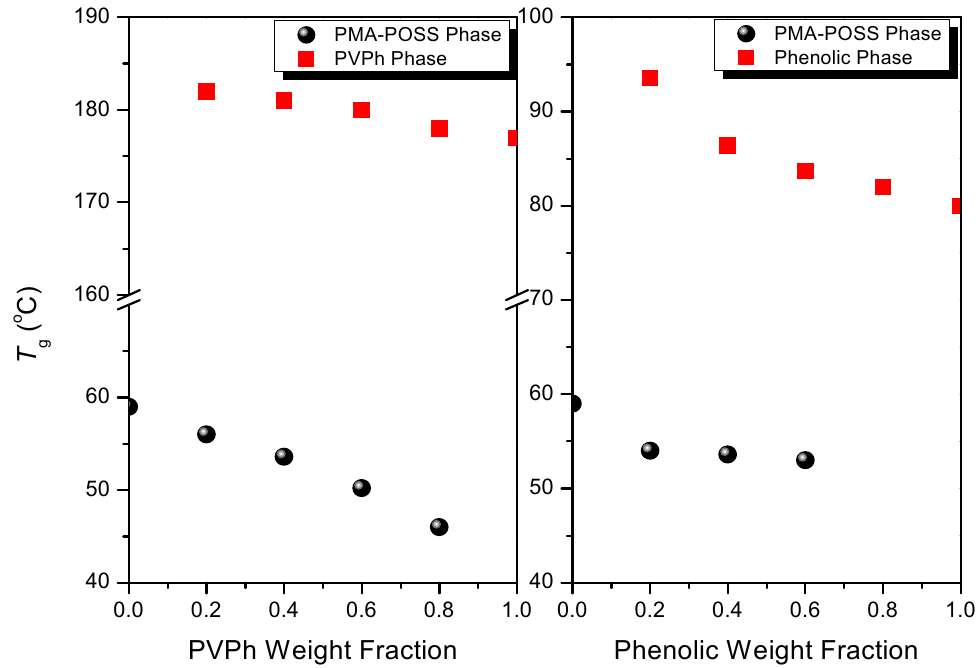
Figure 4. Glass transition temperature–composition curves of ( a ) PVPh/PMA-POSS and ( b ) phenolic/PMA-POSS blends.